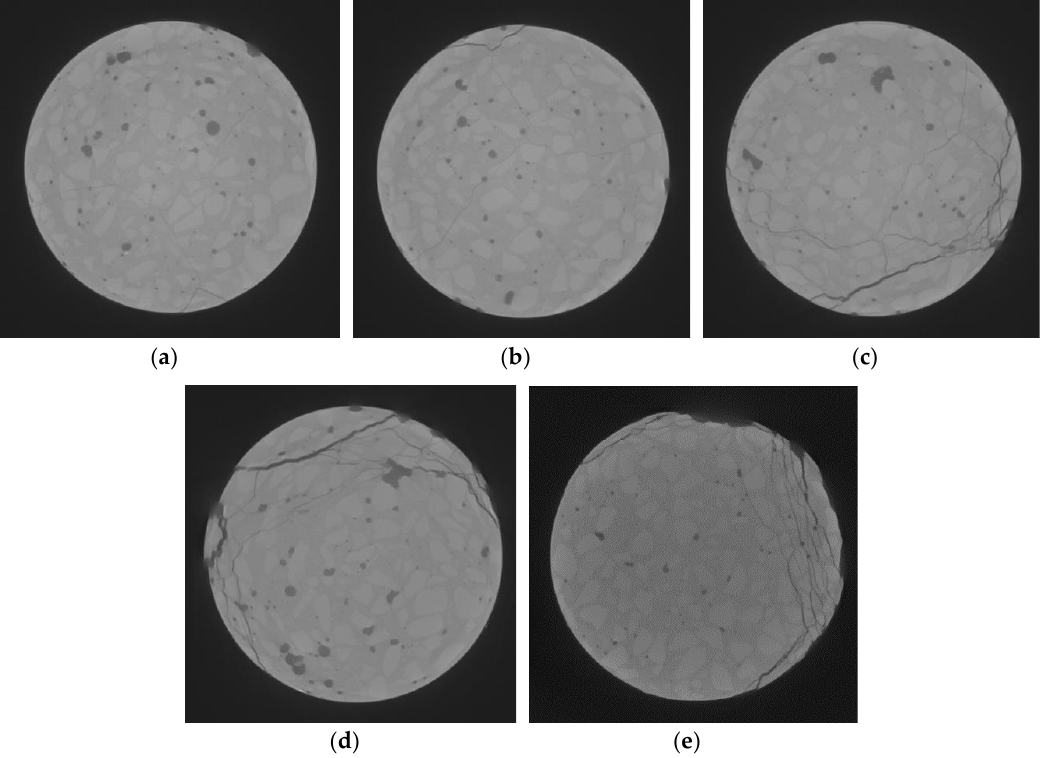
Figure 17. Examples of cracking in specimens of PPFHPC. L-Series under the five different sets of cycles: ( a ) 0 cycles; ( b ) 2000 cycles; ( c ) 20,000 cycles; ( d ) 200,000 cycles; ( e ) 2,000,000 cycles.